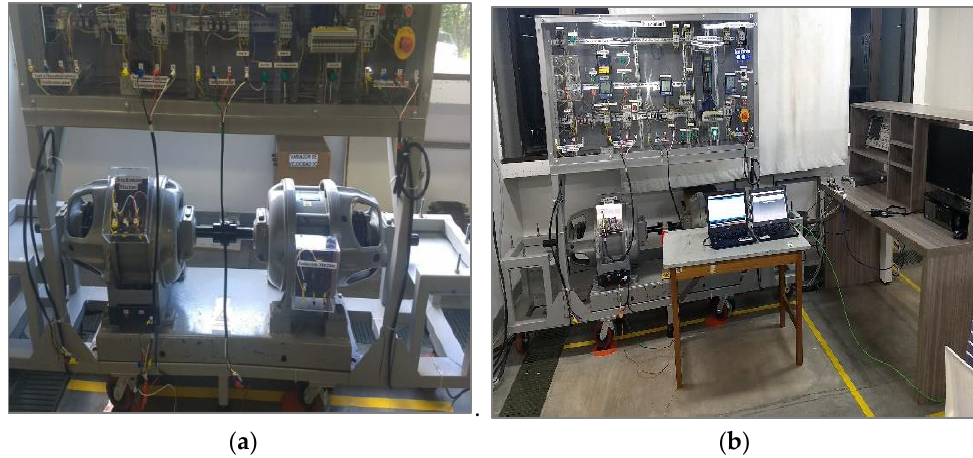
Figure 6. ( a ) A synchronous generator of 5 KVA at 1200 RPM and ( b ) the experiment for the measurement and transmission of information.